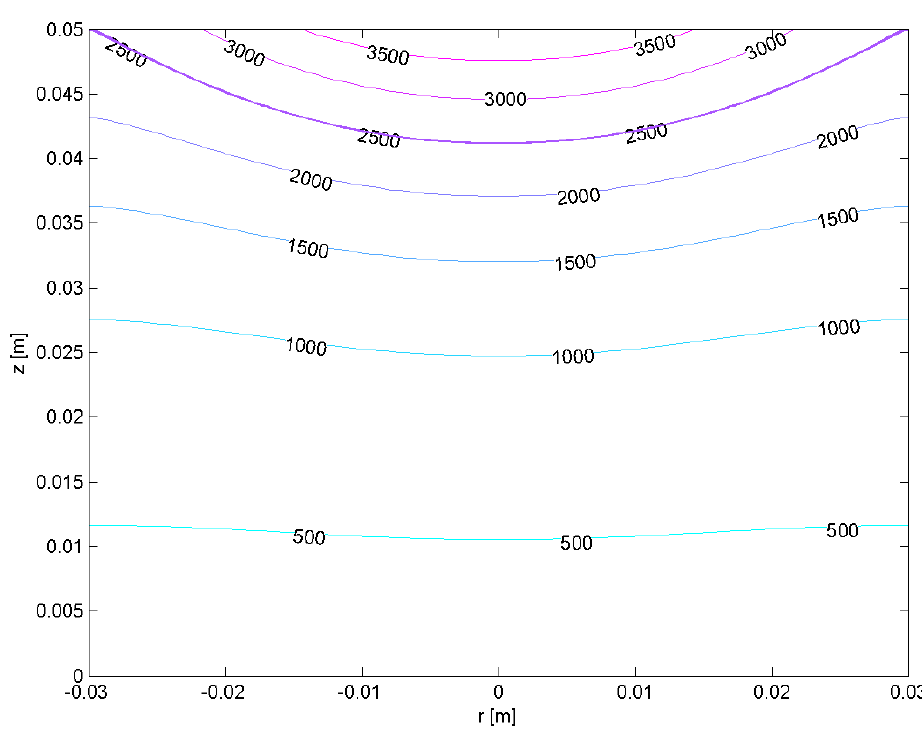
Figure 6. Temperature distribution in a vertical cross-section of Hf ingot ( H = 50 mm, R = 30 mm) at the 295th second of EBM process for P T = 2506 melt